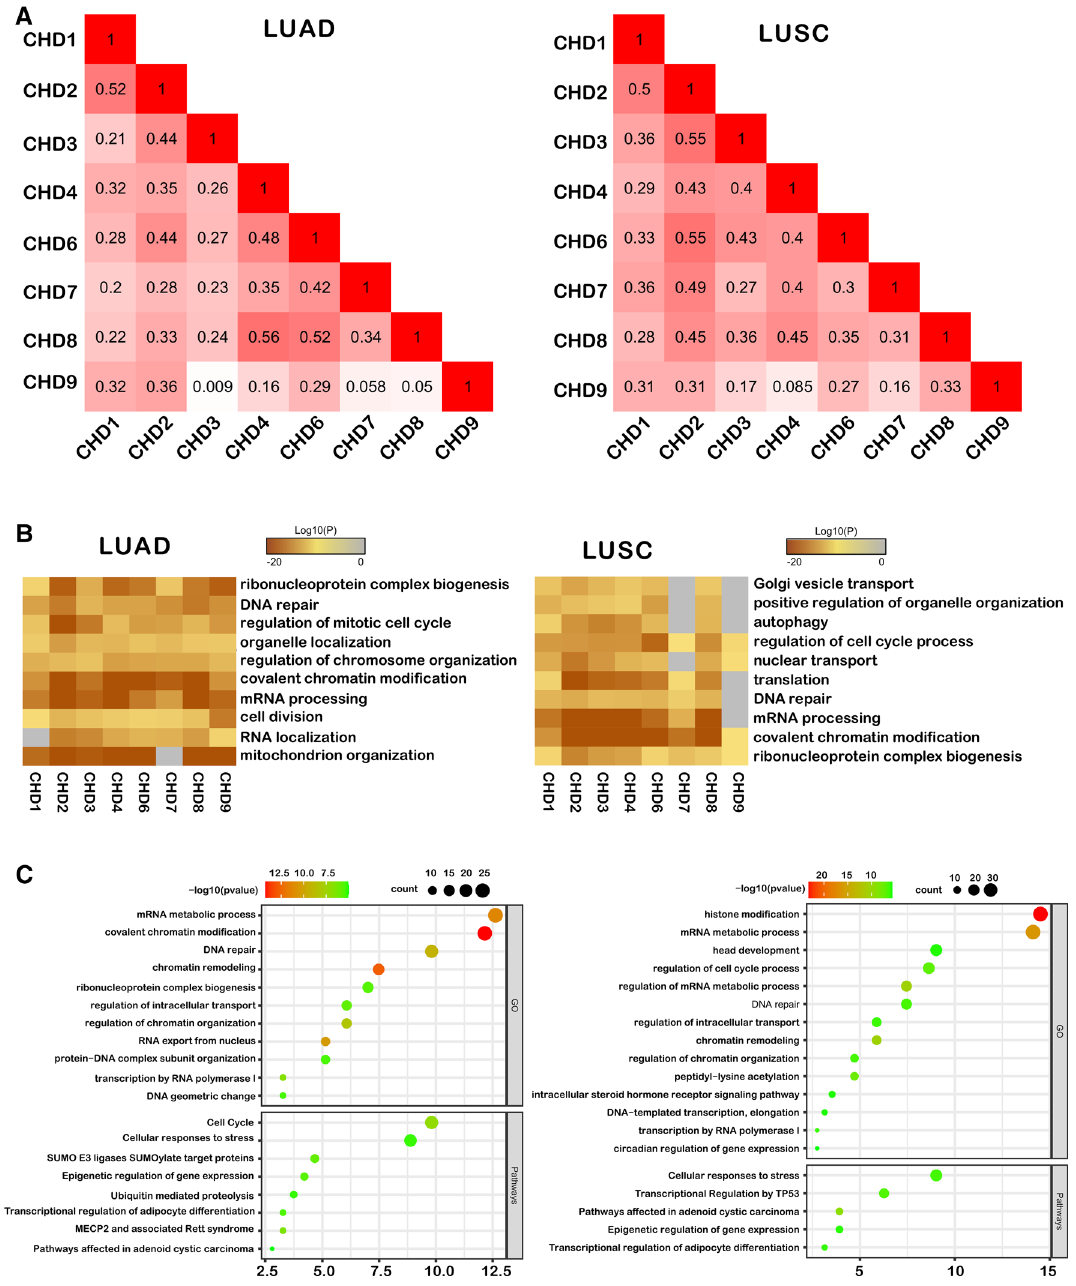
Fig. 5 Functional enrichment analysis of CHDs in patients with lung cancer. A heatmap showing the correlation between different CHDs in LUAD (left panel) and LUSC (right panel); red cells indicate co-occurrence; The numbers in the color blocks represent the r-values; B Gene Ontology enrichment analysis of CHD co-expression genes. LUAD: |r|> 0.4, LUSC: |r|> 0.4; C Bubble diagram displaying the GO and KEGG functional enrichment results of CHD7 co-expression genes (left panel) and CHD8 co-expression genes (right panel). LUAD: |r|> 0.4, LUSC: |r|> a Cox proportional hazards model using TIMER online tools. The results showed that the infiltration of B cells (P = 0.001) and the expression of CHD1 (P = 0.003) and CHD6 (P = 0.012) were significantly correlated with the clinical outcomes of patients with LUAD (Fig. 4D). Unfortunately, we did not find a significantly correlated variable factor in LUSC (Fig. 4D).